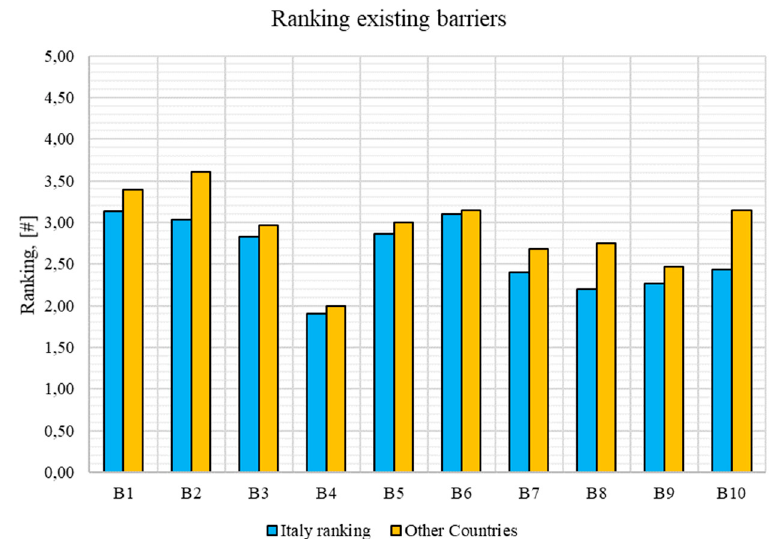
Figure 29. Ranking of the identified existing barriers against the implementation of the LTDH concept. (B1) High investment cost; (B2) the need to locally boost supply temperature; (B3) the need to modify existing business models; (B4) the metering of the thermal energy fluxes to and from the network; (B5) the contractual restrictions about supply temperature conditions; (B6) the limited opportunities for existing substation retrofitting; (B7) the relationship with the customer; (B8) the Legislative / Regulatory / Authorization constraints; (B9) the conflictual relationship between the grid operator, the district heating plant manager, and the eventual manager of the sub-station; (B10) the lack of the required technical